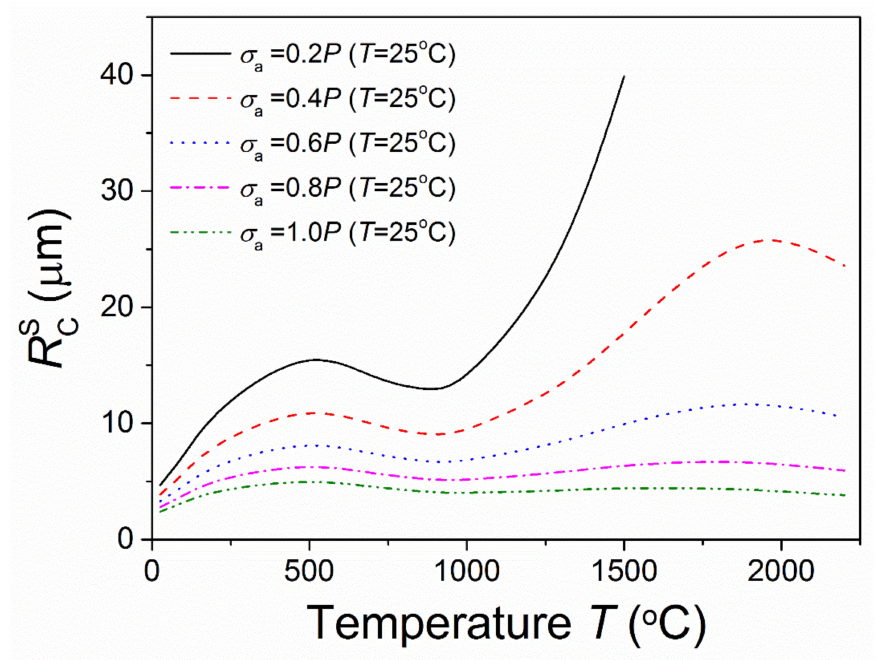
Figure 3. Temperature-dependent critical inclusion size for stress-induced microcracking correspond- ing with different applied